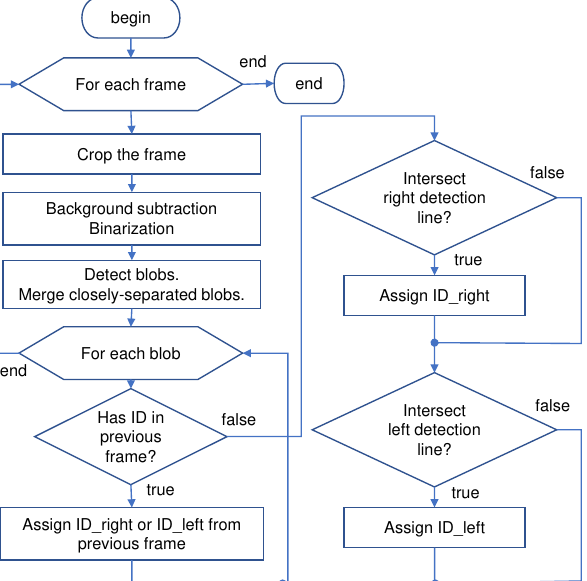
Figure 6. Flowchart for the traffic detection algorithm. Closely spaced blobs within 10 px apart are merged to account for the occlusion from the guardrail. A unique ID is assigned to a sizable blob (60 px-wide minimum) based on its initial position when crossing either of the detection lines. A single-vehicle blob can be assigned with two IDs (right-going <100, left-going >100) to handle momentary occlusion between left-going and right-going vehicles. The final ID is selected based on whether the ID value matches the movement direction.